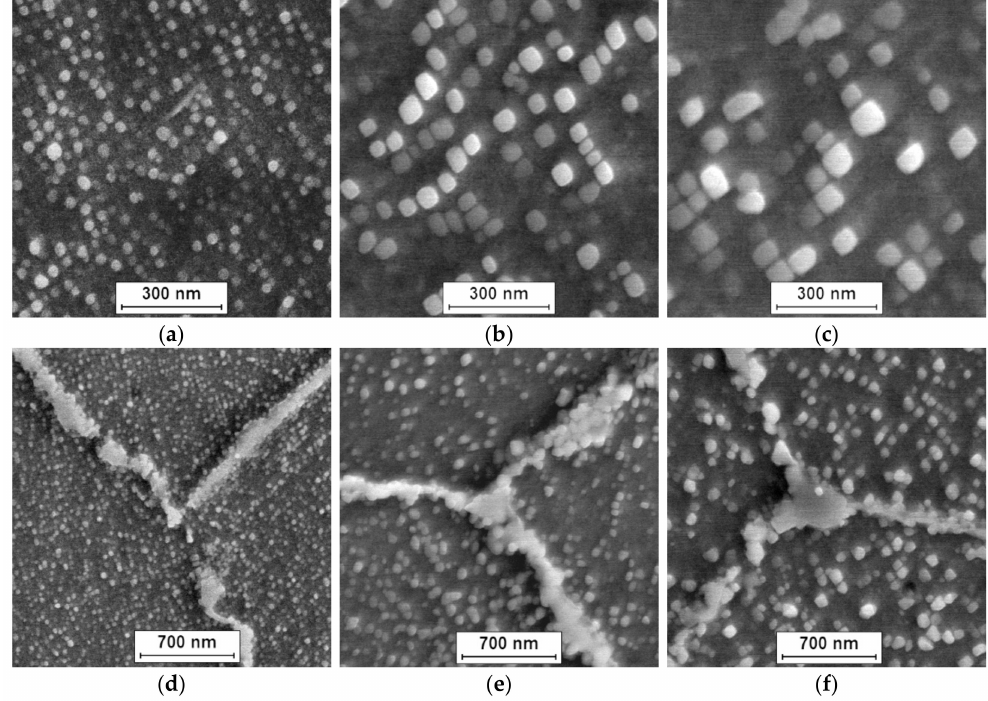
Figure 2. Morphology of γ (cid:48) phase ( a – c ) and Cr 23 C 6 carbides ( d – f ) in Inconel 740H at various times of oxidation at 750 ◦ C. SEM: ( a , d ) 100 h; ( b , e ) 1000 h; and ( c , f ) 2000